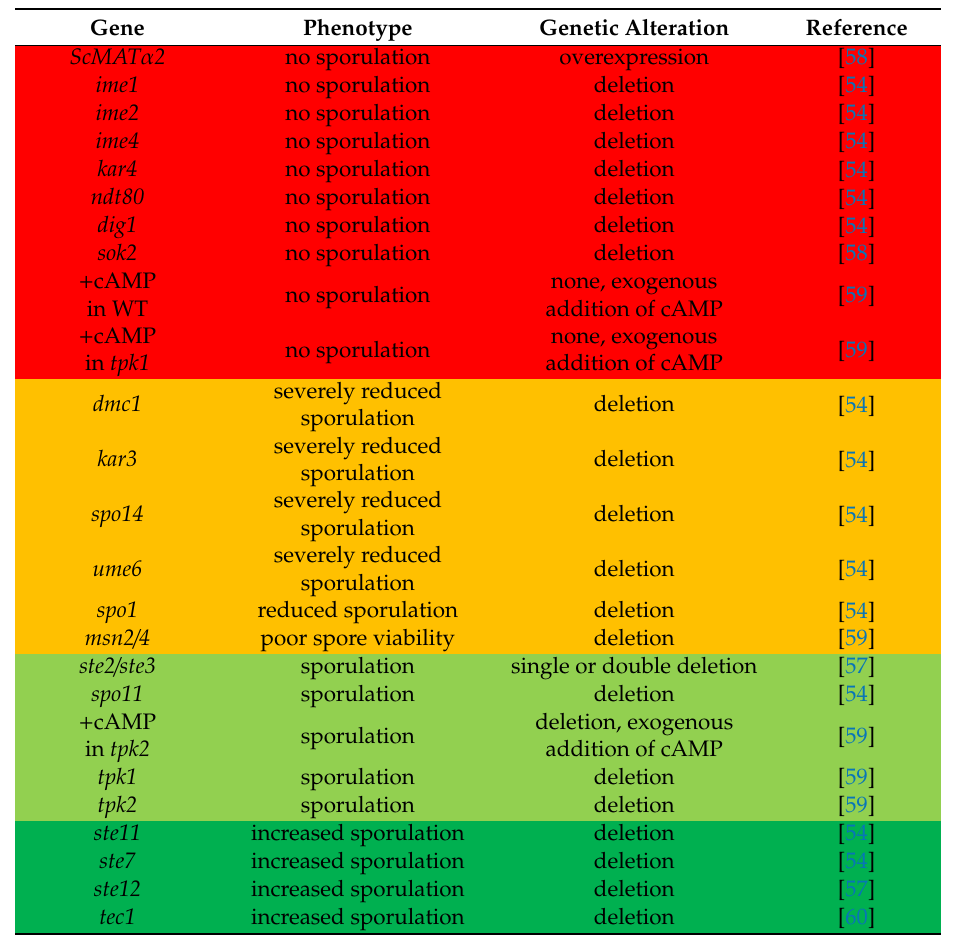
Table 1. Gene-function analyses with respect to sporulation behavior.